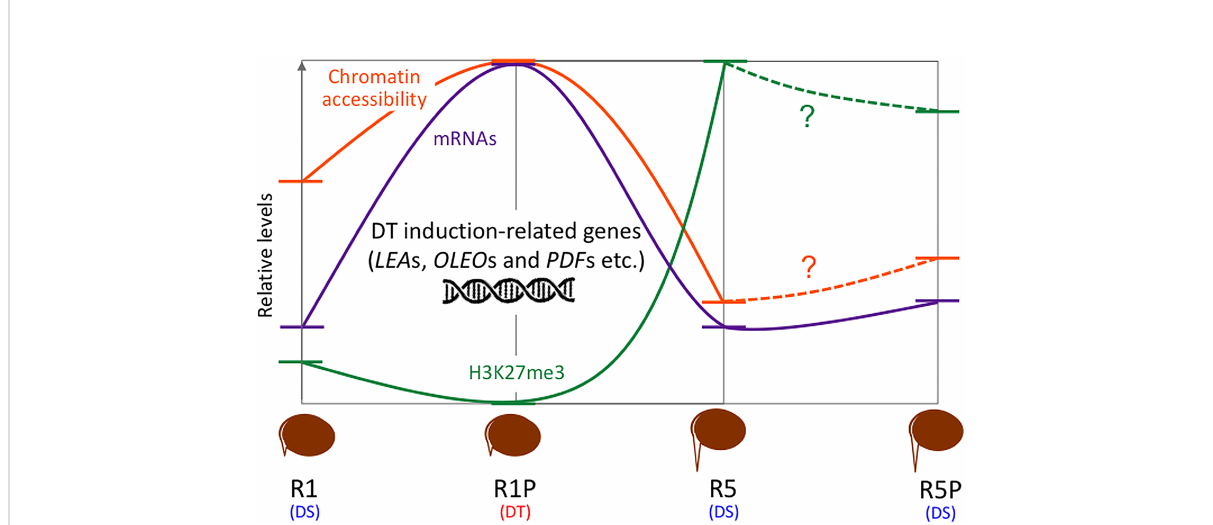
FIGURE 8 Comparative gene ontology (GO) enrichment analysis of DT-DAR-DEGs and DT-nonDAR-DEGs. Signi fi cant GO terms (FDR < 0.05, minimum number of mapped gene > 2, Fold change > 10) in “ biological process ” were obtained. Fold change represents fold enrichment of genes with the given term as compared to ones in the Medicago genome background. The number in the parentheses indicates the number of each DEG in cluster